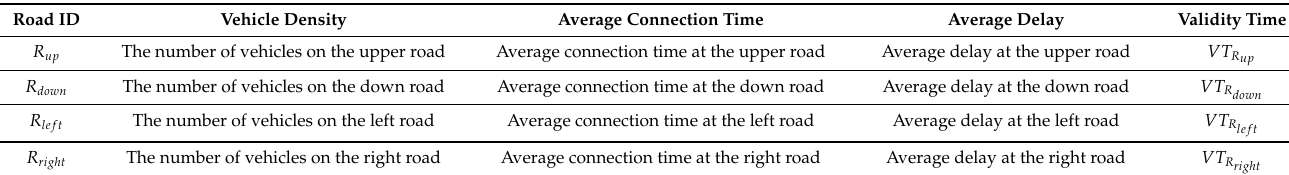
Table 3. Traffic table format.